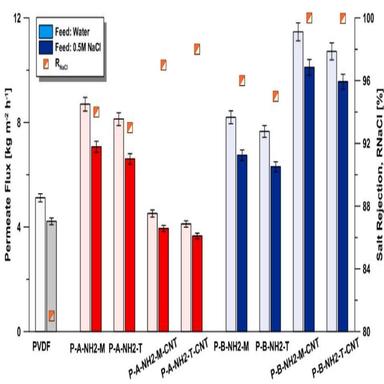
Desalination process with pristine and modified membranes.